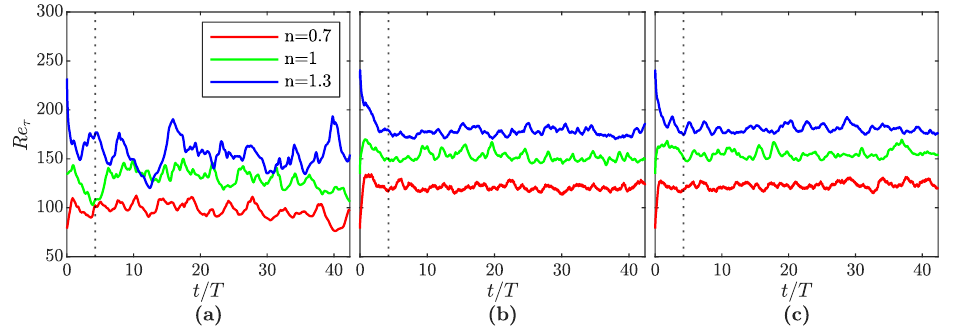
Figure 4. Total instantaneous wall-averaged shear stress τ w , normalized by µ l ( u init τ / H ) to yield Re τ , as a function of the dimensionless time t / T for the single-phase ( a ) and the two-phase setups with Eo = 0.3125 ( b ) and Eo = 3.75 ( c ). Statistics are collected starting at t / T = 4.24, which is indicated by the vertical dotted